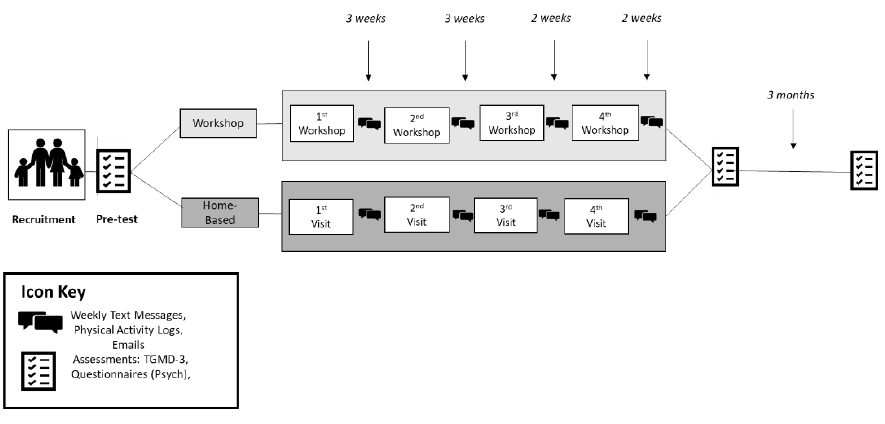
Figure 3. Research Design.